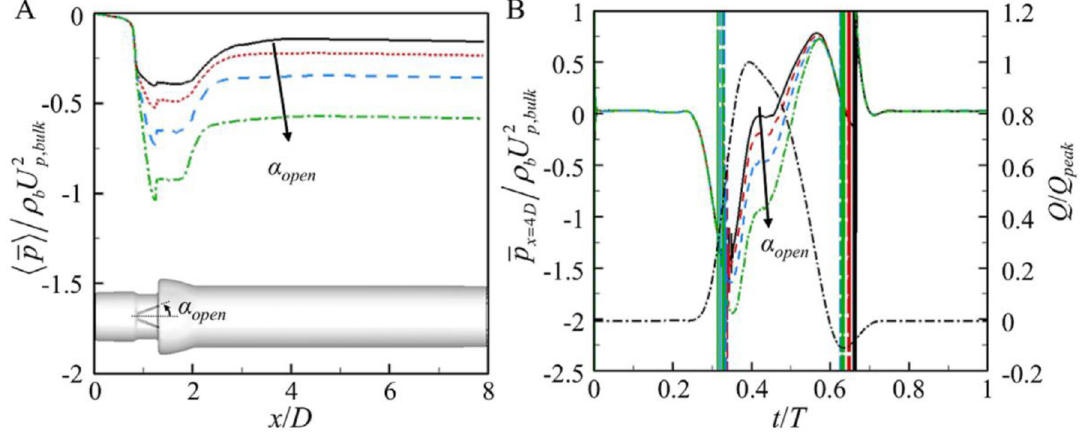
Fig 10. Variation of the plane-averaged pressure with the restricted opening angle (no pannus). (A) Mean systolic plane-averaged pressure along the streamwise direction. (B) Instantaneous plane-averaged pressure at x / D = 4 during one cycle. ▬▬▬ , α 10˚; ▬▬▬ , 15˚; ▬■▬ , 20˚. In (B), ▬ ■ ▬ , inflow rate normalized by the peak inflow